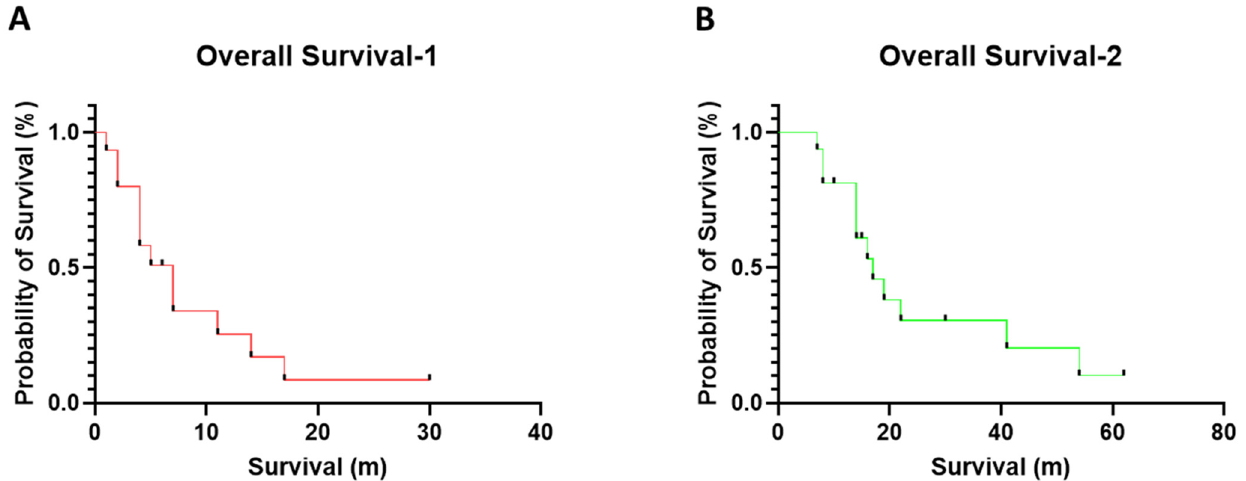
Figure 1. The overall survivals in this cohort with 3q26 aberration/ MECOM-R myeloid